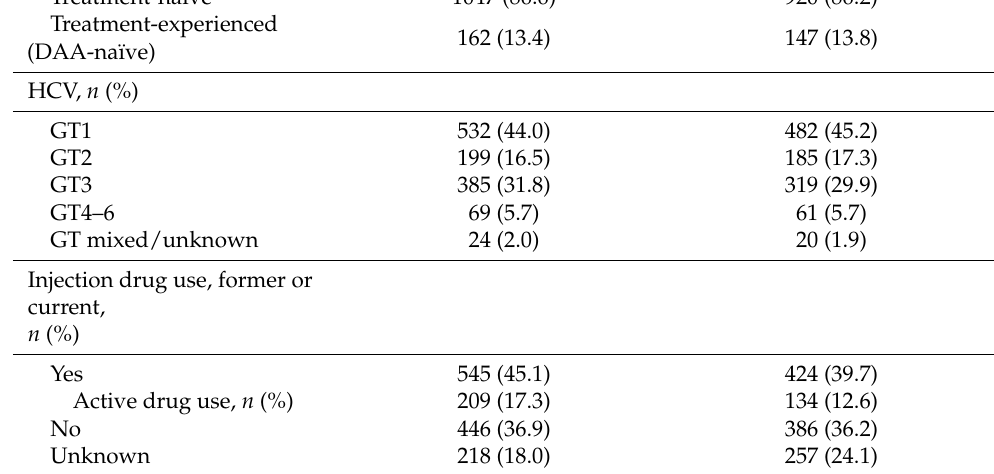
Figure 2. SVR in the effectiveness population, stratified by type of mental health disorder and complicating baseline characteristics. * For 21 patients in the EP, aggregated data for SVR were provided, without breakdown for anti-psychotic drug use. Abbreviations: EP: effectiveness population; SVR: sustained virological response.